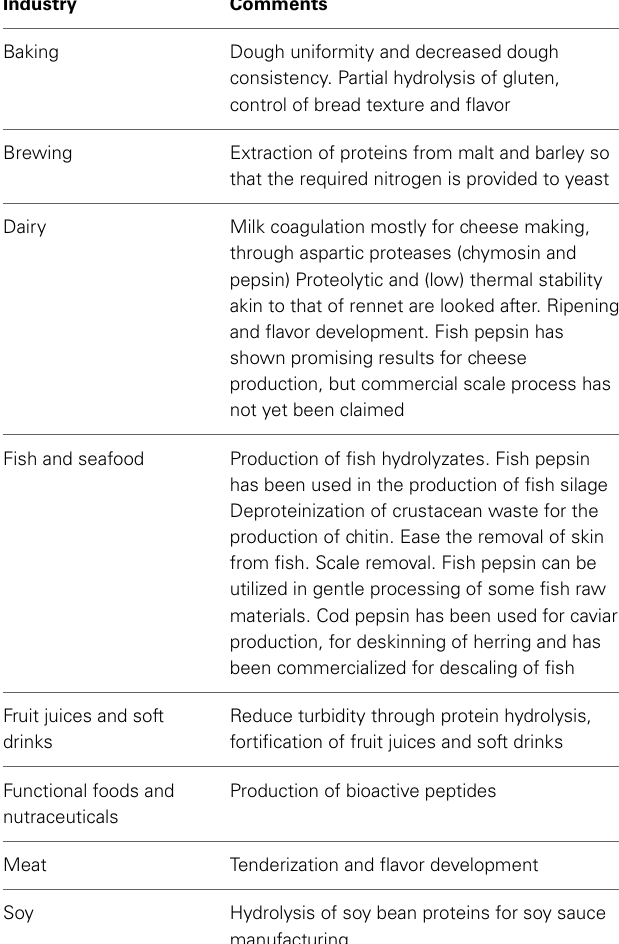
Table 7 | Examples of protease application in food industry (Claverie-MartÌn and Vega-Hernàndez, 2007; Korhonen, 2009; Zhao et al., 2011; Miguel et al., 2013; Steen and Arnosti,